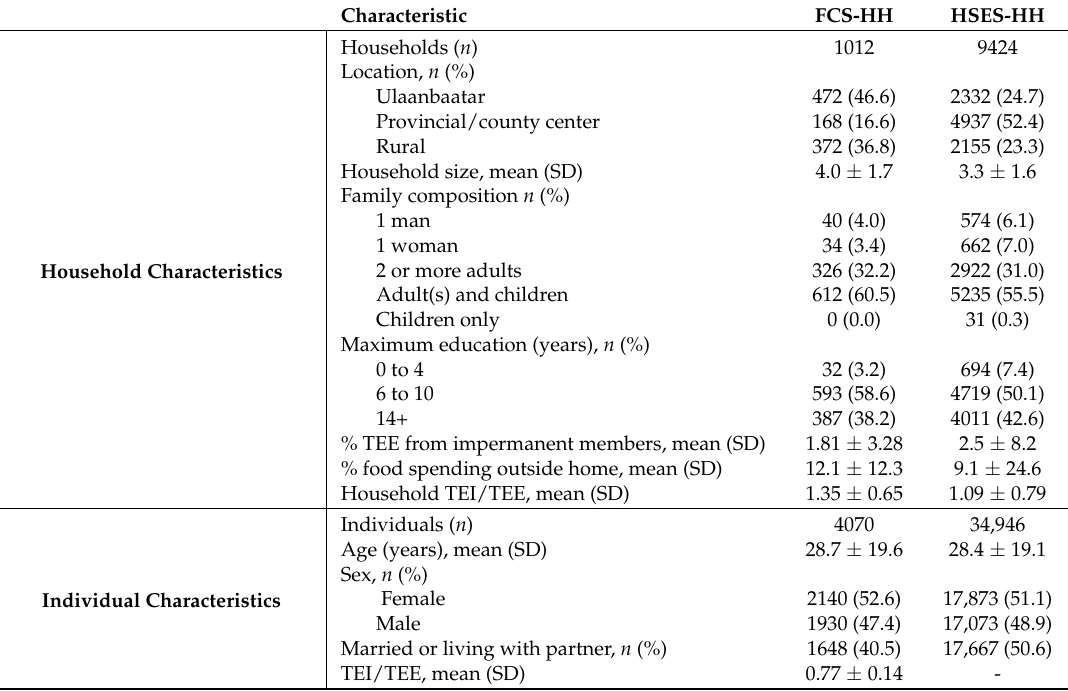
Table 1. Characteristics of households and individuals in the FCS-HH and